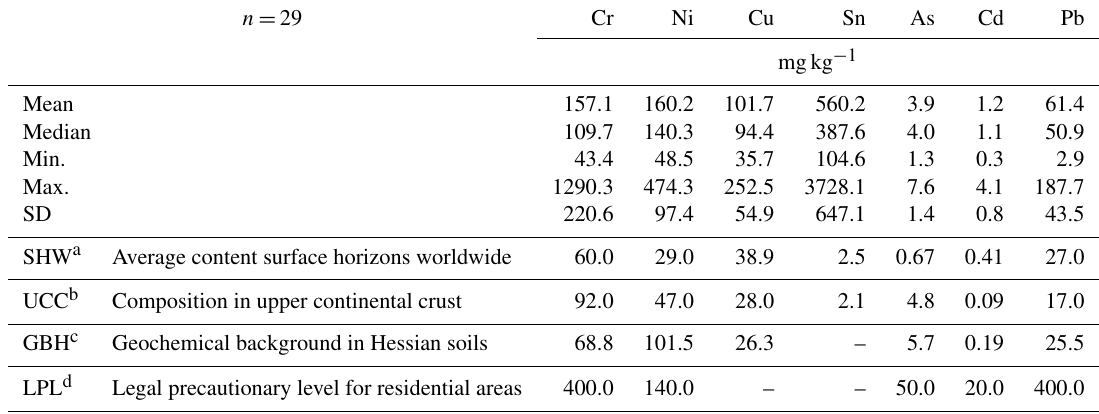
Table 2. Summary of metal and heavy metal concentrations (given in mgkg − 1 ) in pavement joints compared to natural background levels and legislative values. n =